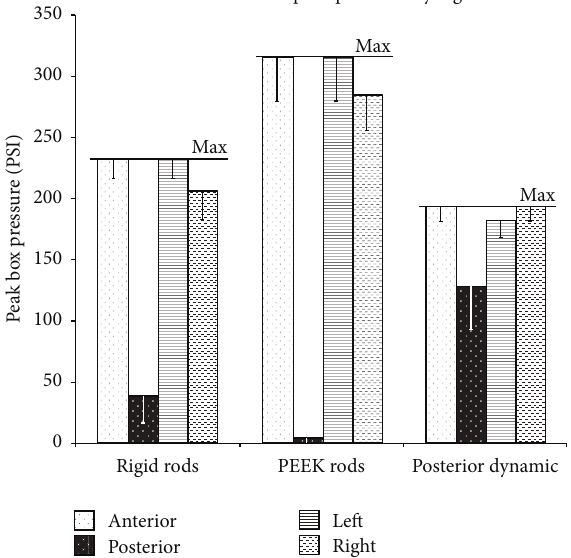
Figure 10: Peak (or maximum) box pressure of the anterior, posterior, left, and right portions of the spacer as measured through the pressure film (according to Figure 4).